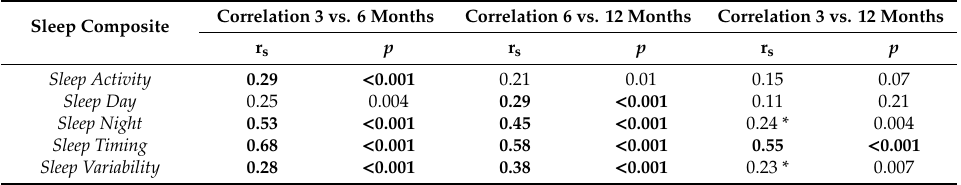
Table 3. Spearman Correlation Coe ffi cients (r s ) of sleep composites across assessment time points. Significant correlations are presented in bold (Bonferroni corrected p -value below 0.0033). The correlation marked with * are significant upon exclusion of outliers: Sleep Variability r s = 0.26, p = 0.002, Sleep Night r s = 0.26, p = 0.001). Composites are most stable across adjacent time points, but only Sleep Timing is stable across the entire first